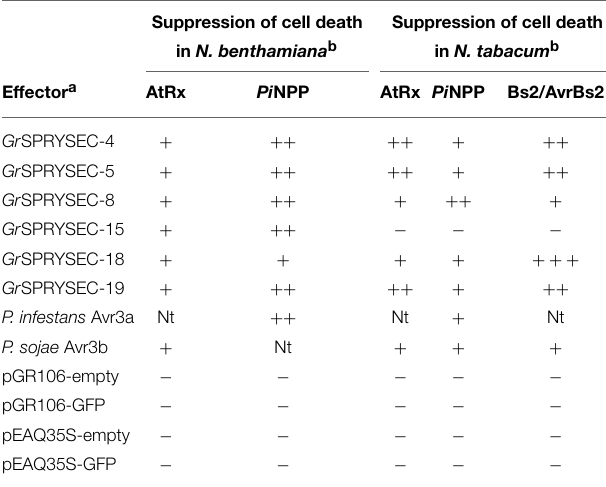
TABLE 1 | Suppression of cell death by G. rostochiensis SPRYSEC proteins. Suppression of cell death Suppression of cell death